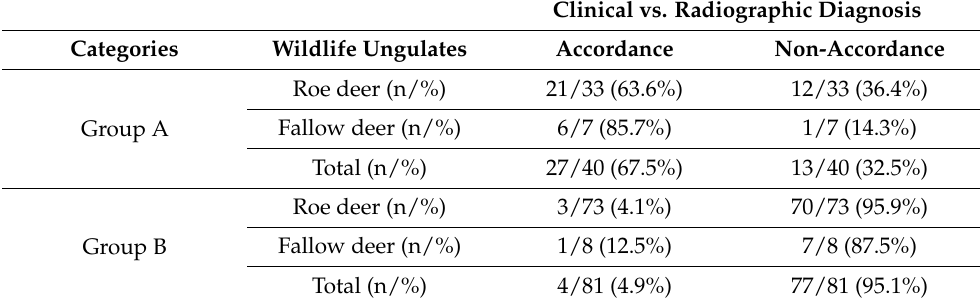
Table 8. Accordance or non-accordance between clinical and radiographic diagnosis in groups A and B, expressed as the number and proportions (n/%) of the roe deer, fallow deer, and total population. Clinical vs. Radiographic